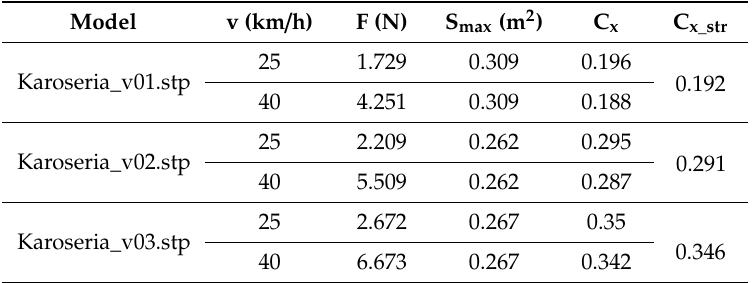
Table 2. Results from numerical calculations.